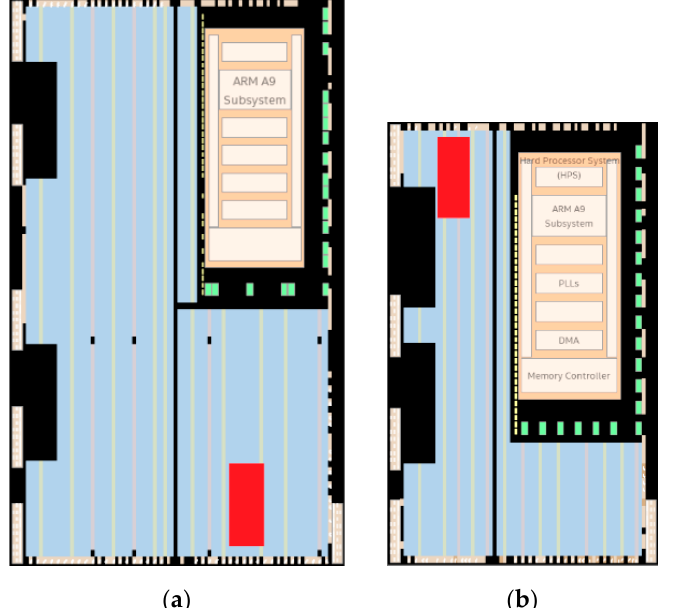
Figure 3. Red boxes signify RO-PUF of ( a ) 5CSEMA5F31C6 (DE1-SoC) and ( b ) 5CSEMA4U23C6 (DE0-Nano).